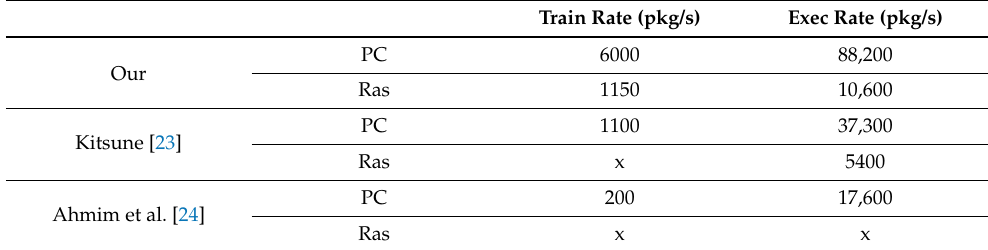
Table 6. Comparing runtime performance between Realguard and its competitors.